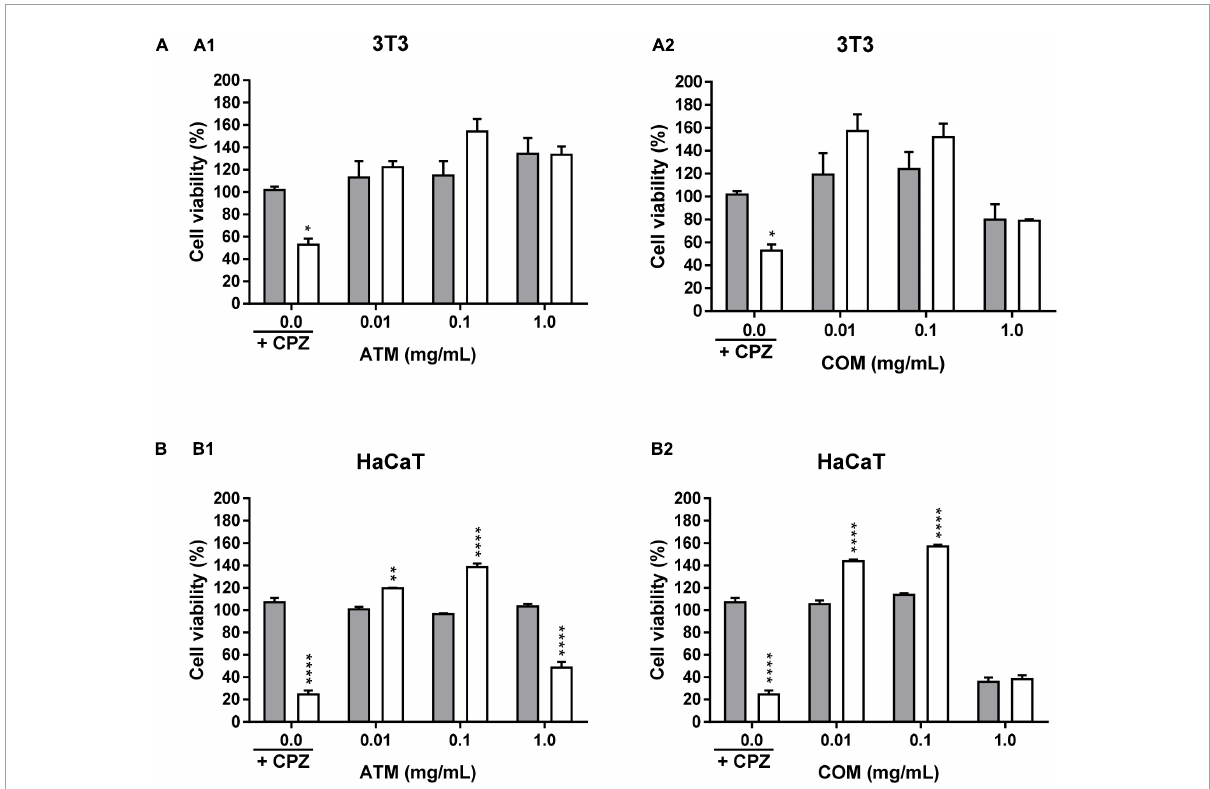
FIGURE4 Phototoxicity activity of ATM (1) and COM (2) in 3T3 (A) and HaCaT (B) cell lines by MTT assay and expressed as a percentage of cell viability with respect to the correspondent control cells Chlorpromazine cell viability was used as positive control. Gray columns correspond to cells nonexposed to UVA light and white columns correspond to cells exposed to 1.8 J/cm 2 of UVA light. Results are expressed as mean ± standard error of n = 3. A two-way analysis of variance (ANOVA) and a Bonferroni post hoc assay have been performed. Statistical differences were considered as follows: * p ≤ 0.05, ** p ≤ 0.01, and **** p ≤ 0.0001 comparison with the equivalent nonirradiated condition